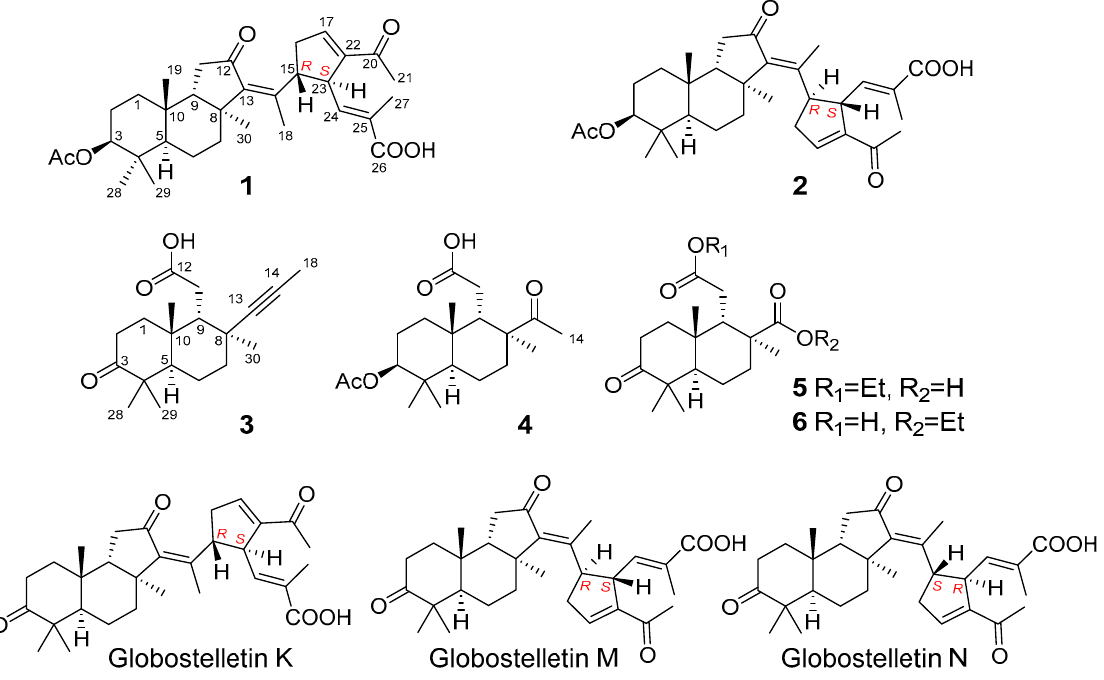
Figure 1. Structures of compounds 1 – 6 and globostelletins K, M, and N. Stellettin Q ( 1 ) was isolated as a yellow oil with molecular formula C 32 H 44 O 6 deduced